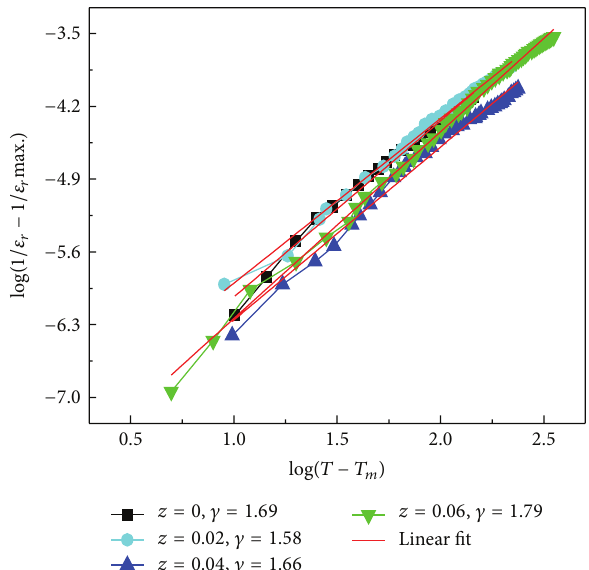
Figure 4: The Log( 1/𝜀 𝑟 − 1/𝜀 𝑟 max ) versus log( 𝑇 − 𝑇 𝑚 ) of [ 1 − 𝑧 (BLNLT)- 𝑧 (BT), 𝑥/𝑦/𝑧 = 0.04/0.025/0–0.06] system at 100kHz.